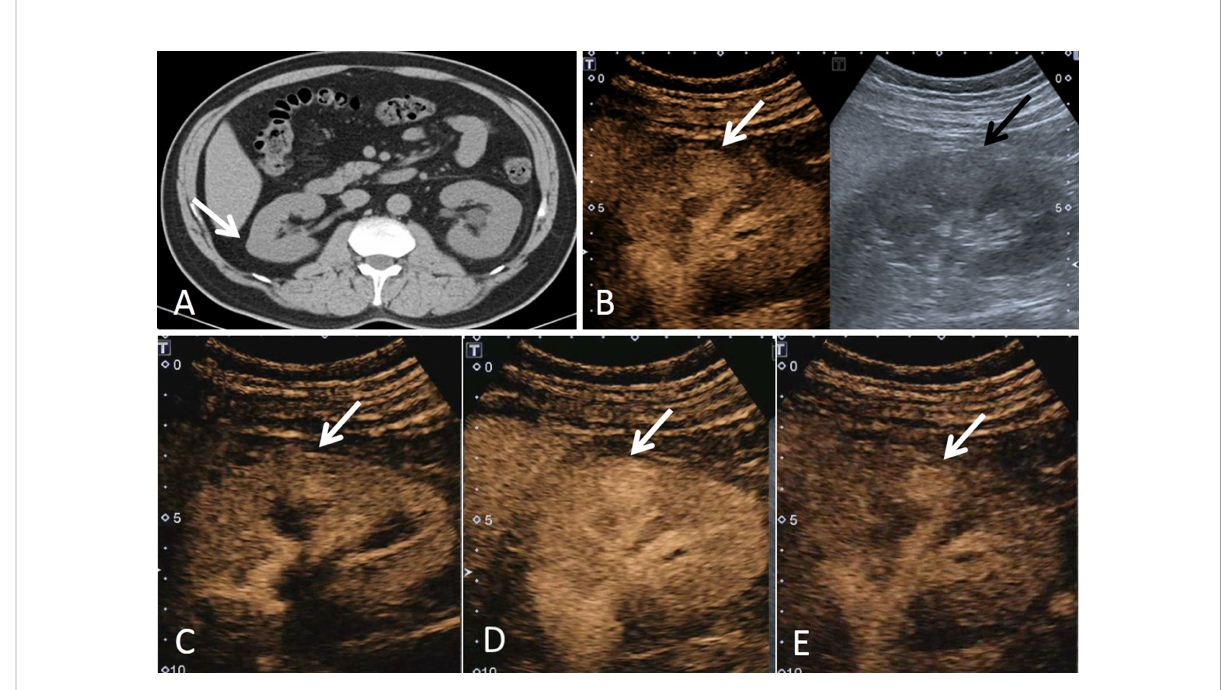
FIGURE 1 A 43-year-old man had a ccRCC in the right kidney with the size of 1.6 × 1.5 cm. (A) Non-enhanced CT showed a suspicious lesion in the middle of the right kidney (white arrow). (B) According to the position displayed on CT, the simultaneous display mode of conventional ultrasound (CUS, right) and contrast-enhanced ultrasound (CEUS, left) was performed, and CEUS showed a lesion with hyperenhancement (white arrow), but it was not detected on CUS (black arrow). (C) On CEUS imaging, it showed that the contrast agent entered the mass synchronously with the adjacent renal cortex (white arrow). (D) At the peak of enhancement intensity, it showed homogeneous hyperenhancement compared with that of the renal cortex (white arrow). (E) When the contrast agent discharged from the mass, it showed a slow-out pattern compared to the adjacent cortex (white